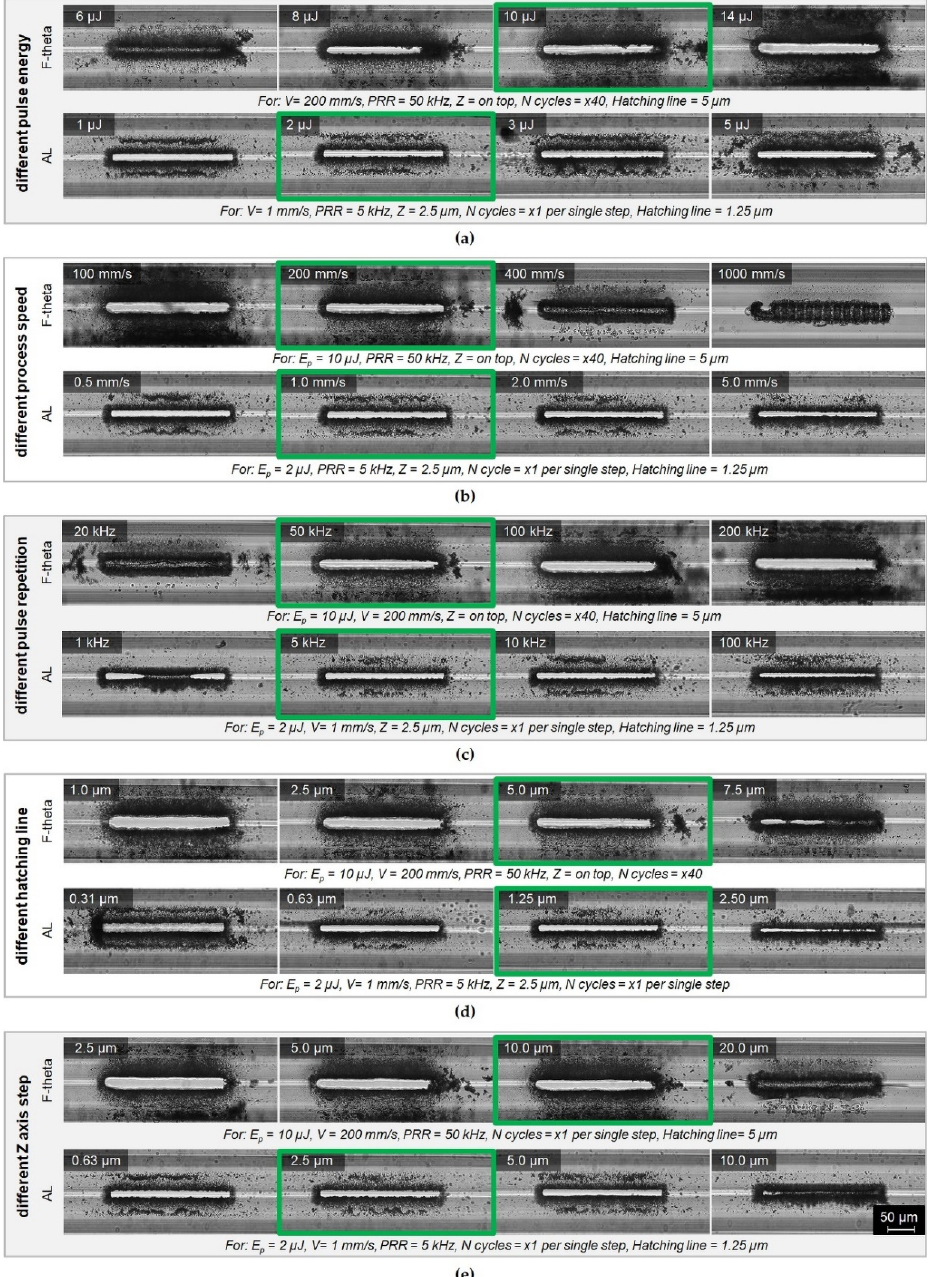
Figure 4. Microscope photographs of microchannels fabricated with the aid of a laser using a galvanometer scanner with an F-theta lens—F-theta and a setup based on a moving field and an aspherical lens, AL. Results are presented for varying parameters: ( a ) pulse energy, ( b ) scanning speed, ( c ) pulse repetition frequency, ( d ) different hatching lines, and ( e ) the Z-axis step of the beam focus